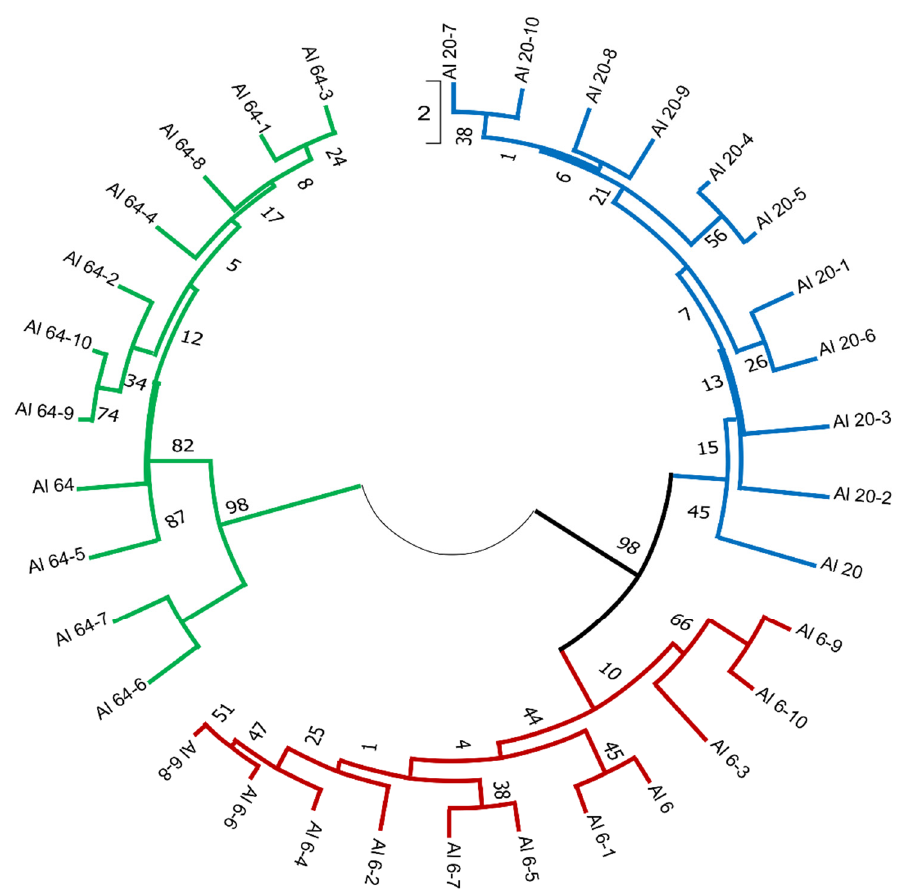
Figure 5. An UPGMA dendrogram analysis of 3 A. ledebourianum populations.